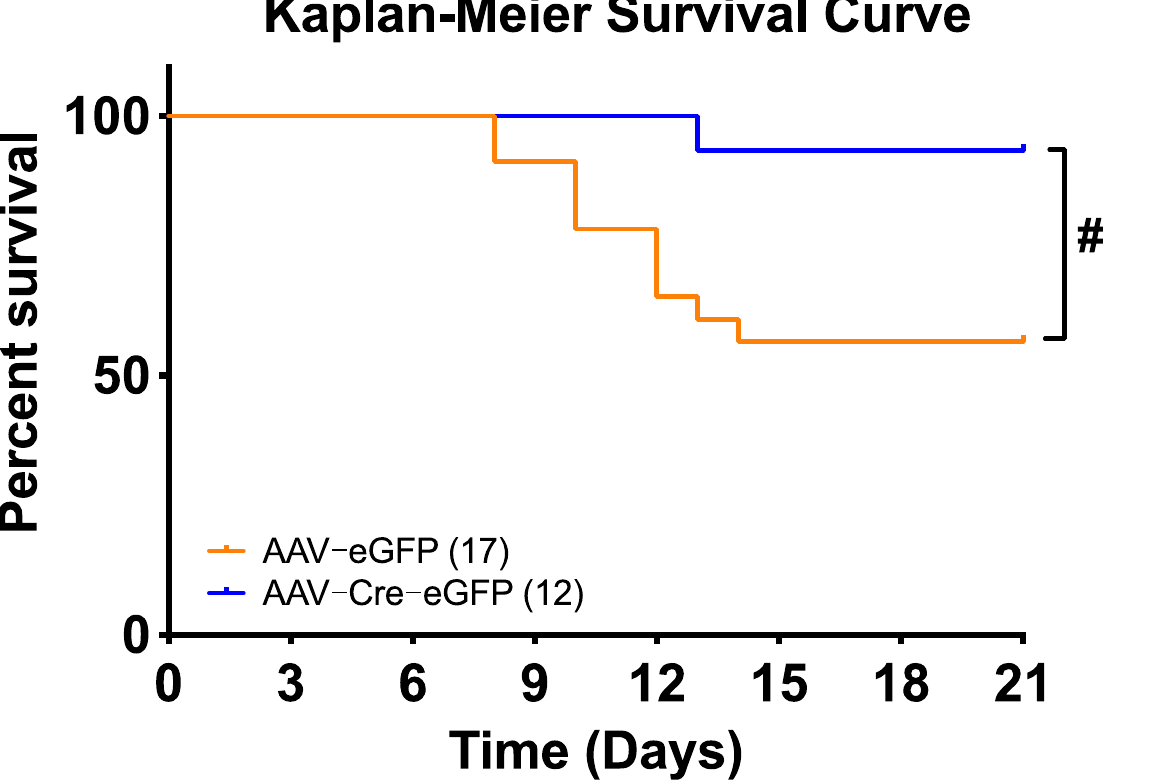
Figure 6. Renin-a ablation in the SFO improves survival rate following DOCA-salt treatment. Kaplan–Meier survival curves during 21-day DOCA-salt treatment. # p < 0.05 versus AAV2-eGFP